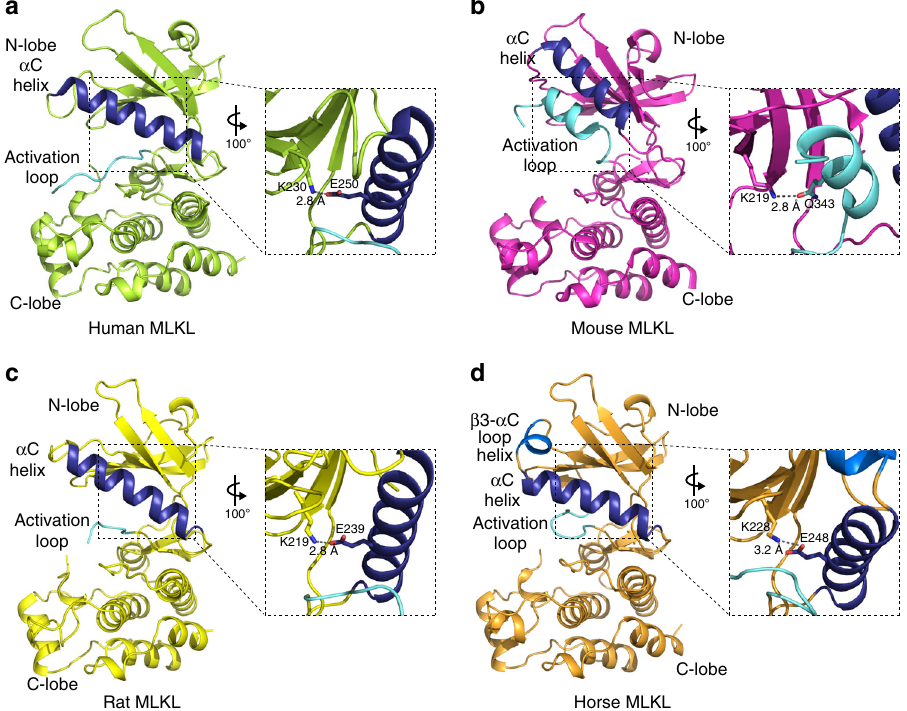
Fig. 2 Rat and horse MLKL pseudokinase domain structures diverge from mouse MLKL. a The structure of the human MLKL pseudokinase domain (PDB, 4MWI 39 ) shows a conventional active kinase-like conformation. The K230 – E250 salt bridge (equivalent of the K72-E91 PKA interaction) between the β 3 ATP-binding lysine and the Glu in the α C helix (shown in dark blue throughout) is shown in the zoomed inset. b The mouse MLKL pseudokinase domain (from PDB 4BTF 18 ) shows a more open conformation owing to the activation loop adopting an unusual helical conformation (pale blue), which displaces the α C helix (dark blue). An unconventional interaction between the β 3 K219 and the activation loop Q343 results (zoomed inset). c The rat MLKL pseudokinase domain adopts an active protein kinase-like conformation, resembling that of the human structure. The β 3 K219 forms a conventional salt bridge with the α C helix E239 (zoomed inset), rather than a hydrogen bond with the activation loop Gln observed in the mouse structure. d The horse MLKL pseudokinase domain shows a similar active protein kinase-like conformation, with the K228:E248 salt bridge shown in the zoomed inset. The horse structure exhibits previously unobserved features, including burial of the activation loop in the pseudoactive site and an additional helix in the β 3- α C loop (displayed in more detail in Fig.